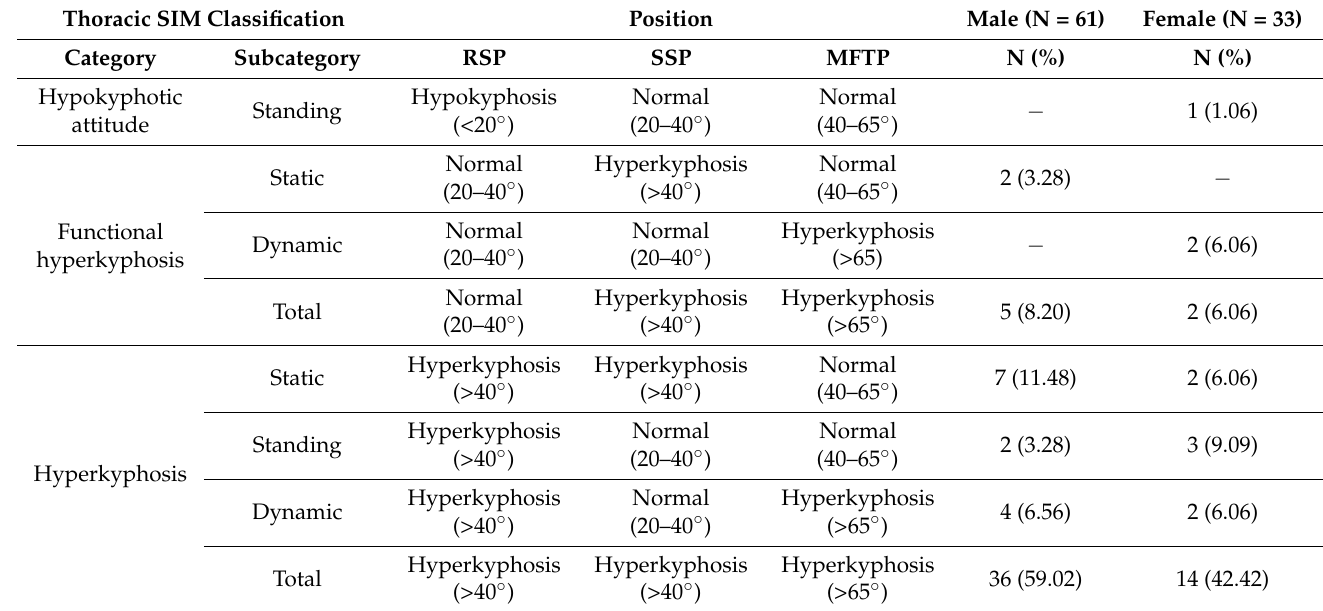
Table 3. Absolute and relative frequencies of SIM (sagittal integral morphotype) misalignments for thoracic curvature in competitive amateur